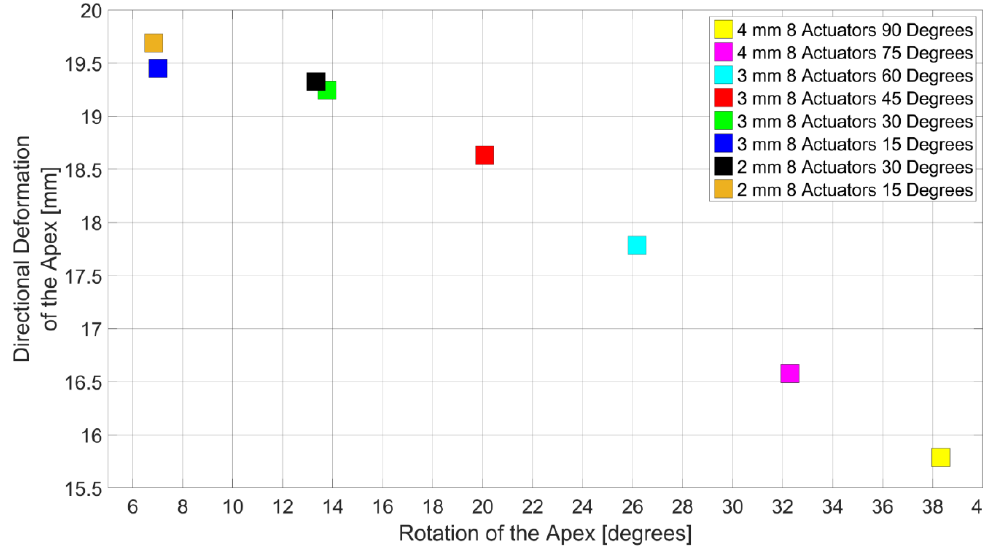
Figure 12. Configurations with the highest directional deformation and the highest rotation in the subdomains.